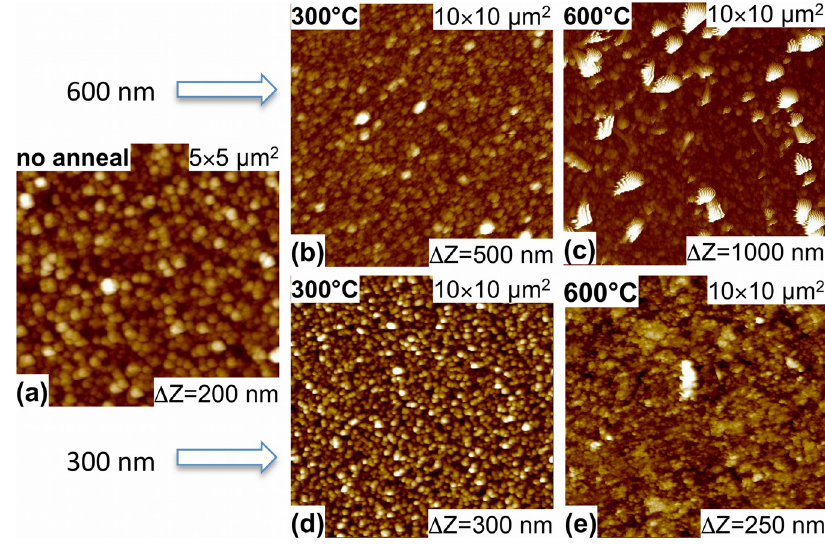
Figure 1. AFM topography images of ( a ) Zn-metal films before oxidation (grayscale range = 200 nm) and the resulting polycrystalline ZnO films after annealing in ambient air; Six hundred nanometer-thick films annealed at ( b ) 300 ◦ C (grayscale range = 500 nm) and ( c ) 600 ◦ C (grayscale range = 1000 nm). Two hundred nanometer-thick films annealed at ( d ) 300 ◦ C (grayscale range = 300 nm) and ( e ) 600 ◦ C (grayscale range = 250